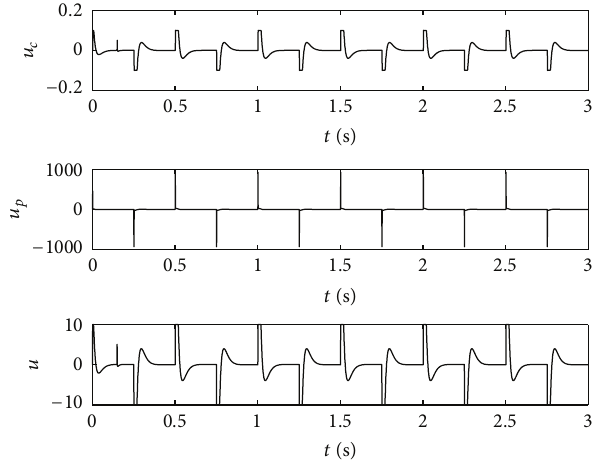
Figure 2: Square signal tracking curve of compound control. Figure 3: Output signal of compound control.